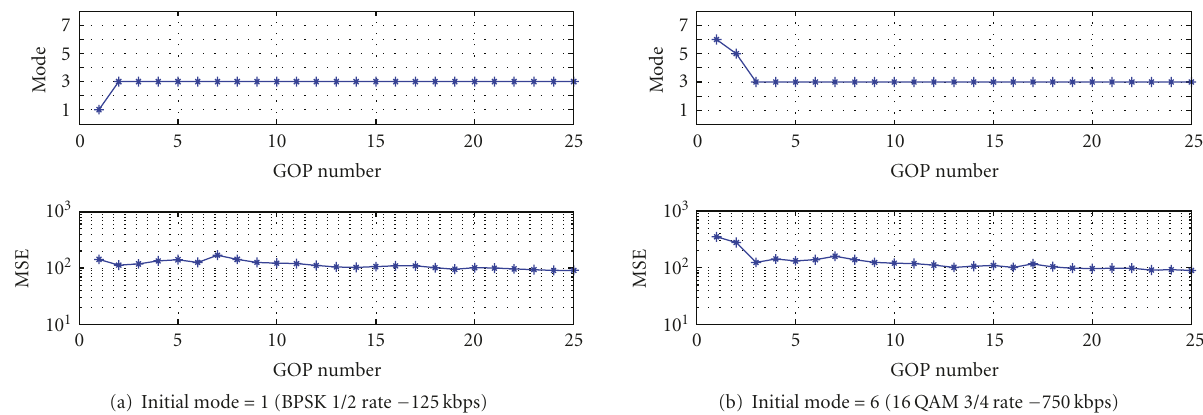
Figure 15: Mode and estimated distortion for coastguard encoded with C/N = 15dB, Set (a).